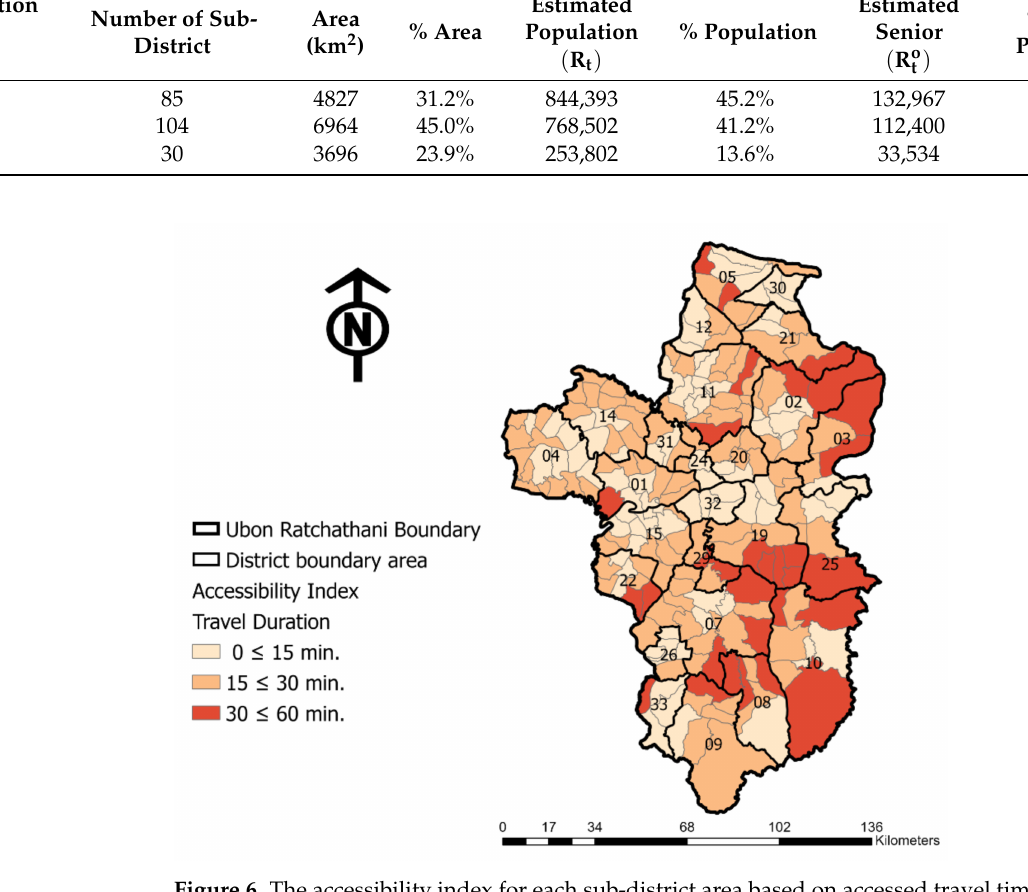
Figure 6. The accessibility index for each sub-district area based on accessed travel time